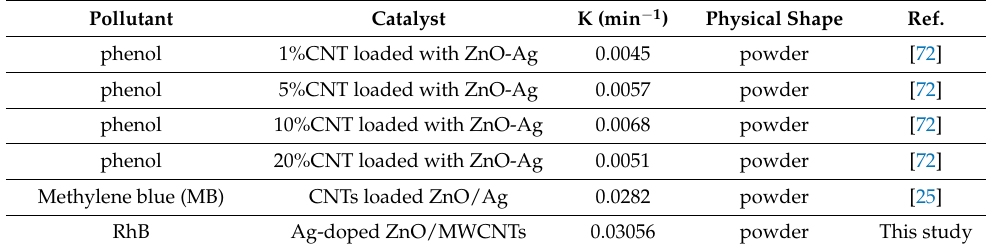
Table 1. The catalytic degradation of different organic pollutants over other nanocomposite-based Ag/ZO/MWCNTs